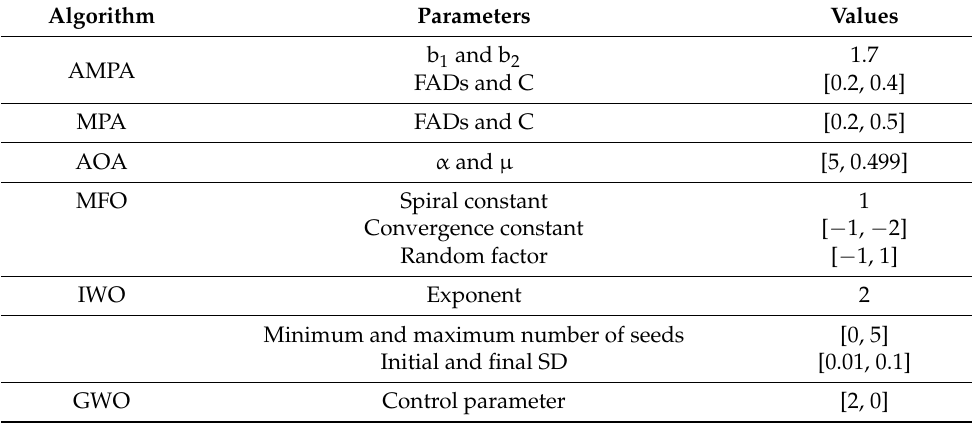
Table 1. Parameter settings of the